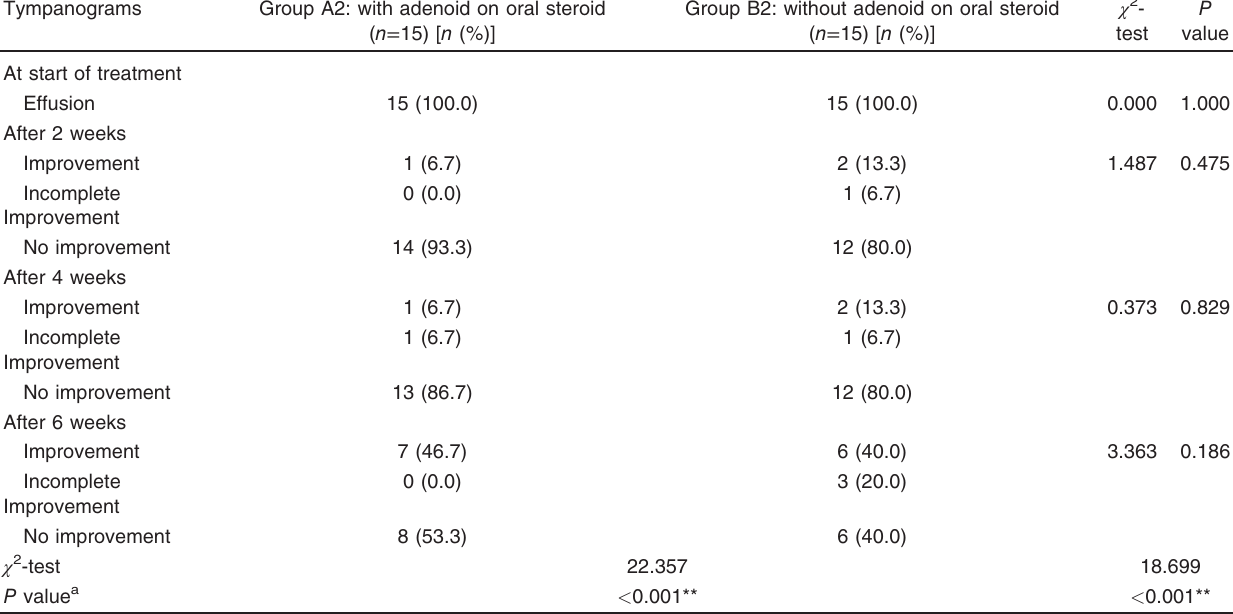
Table 10 Comparison between group A2, with adenoid on oral steroid, and group B2, without adenoid on oral steroid according to tympanograms Tympanograms